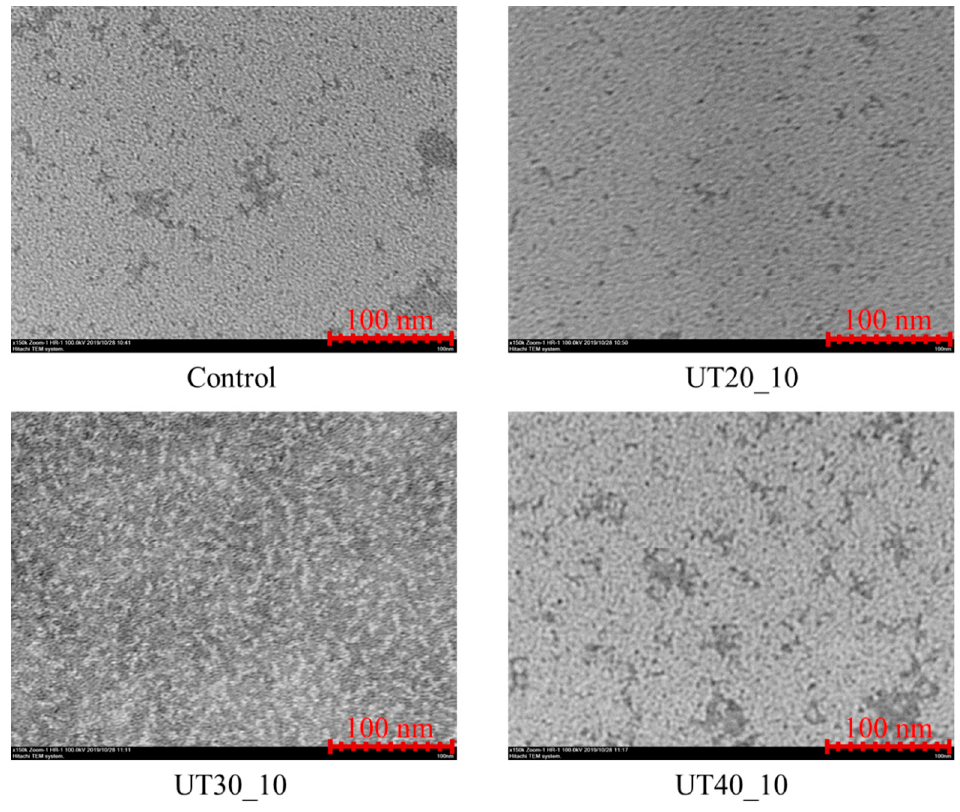
Figure 7. Transmission electron microscopy photographs (×150,000) of the goat milk β -lactoglobulin treated by HIU in different amplitudes (20, 30, and 40%) for 10 min.